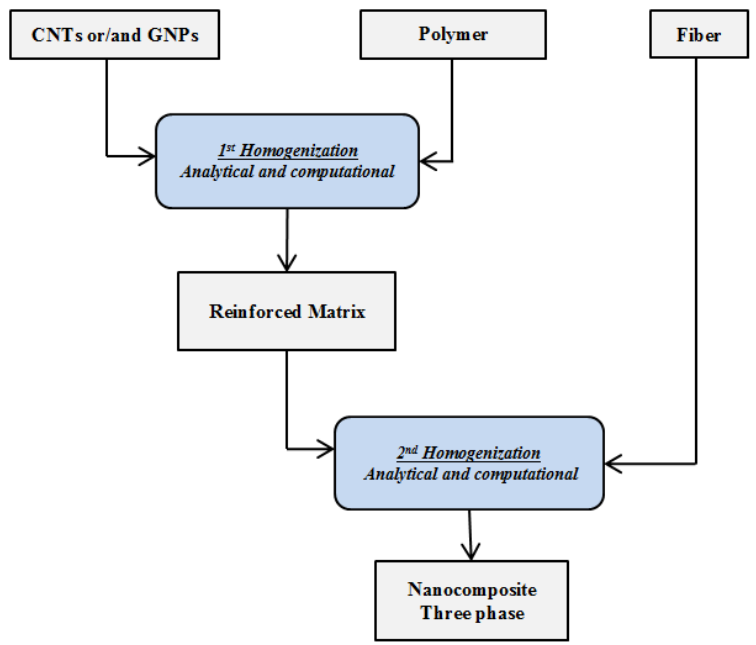
Figure 1. Multiscale analysis procedure of three-phase nanocomposite homogenization. 2. First